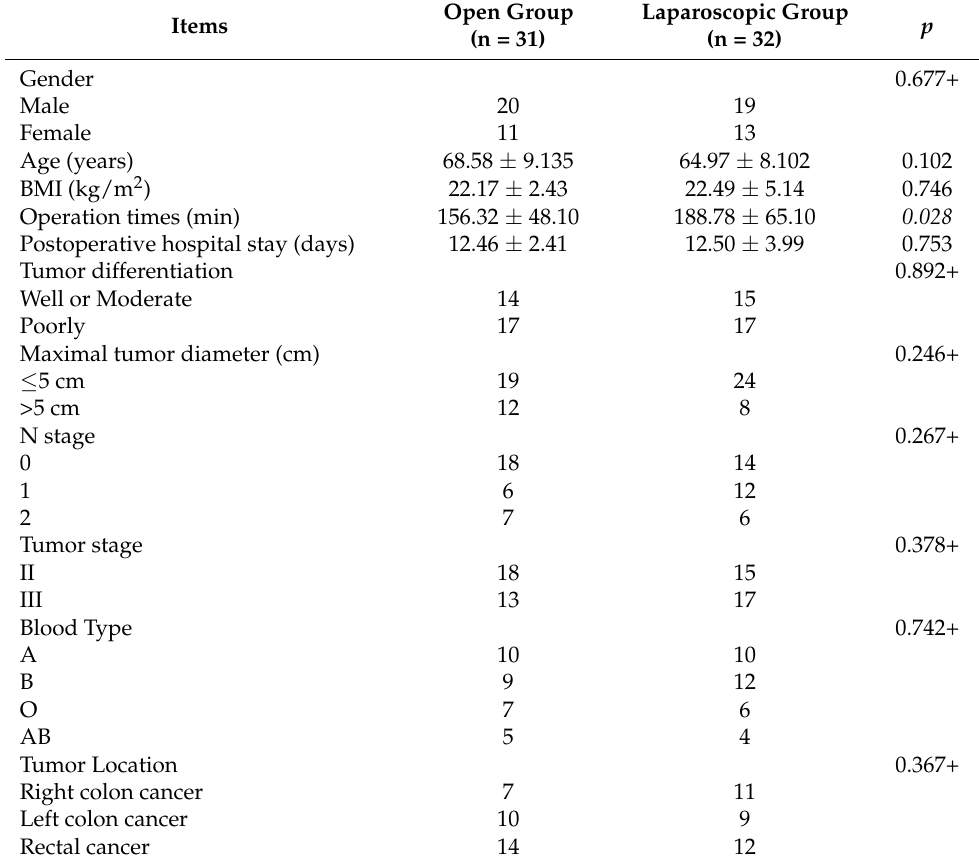
Table 1. General material comparison in perioperative period of the open and laparoscopic groups (x ± s).